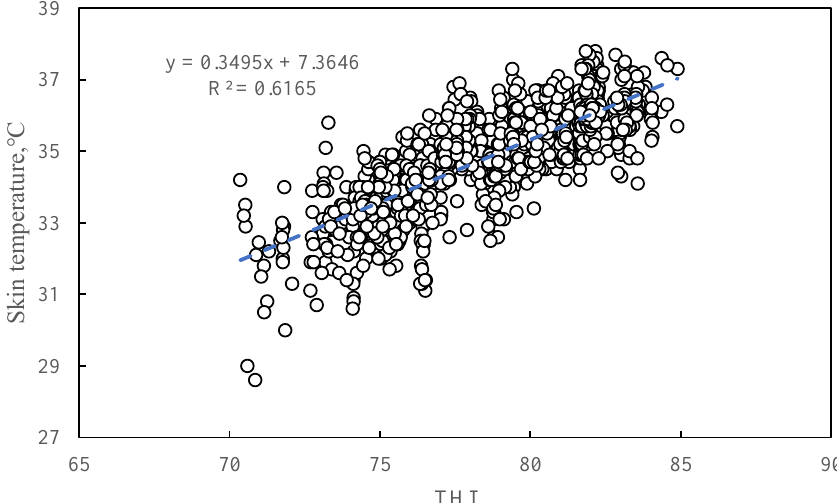
respiration rate (breaths · min − 1 ) and x stands for THI) (R 2 = 0.1386, p < 0.0001).